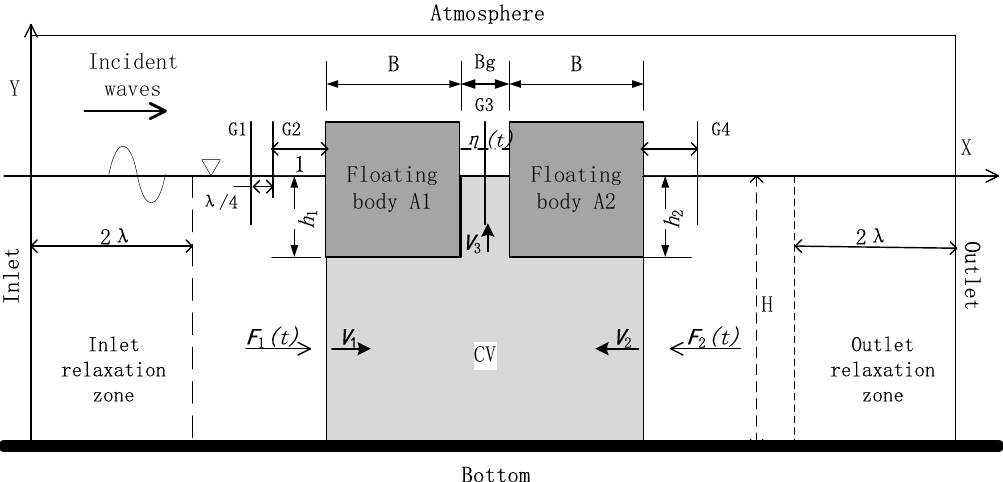
Figure 1. Sketch of flow oscillation in the narrow gap between two floating bodies.